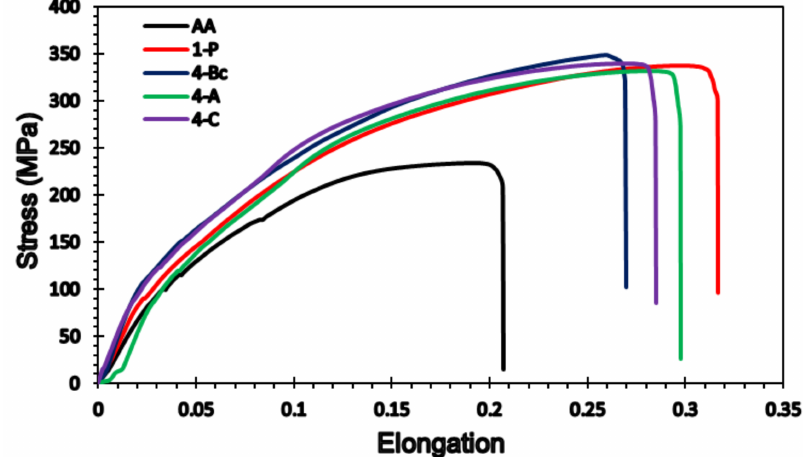
Figure 14. Stress–strain curves of ZK30 billets before and after ECAP